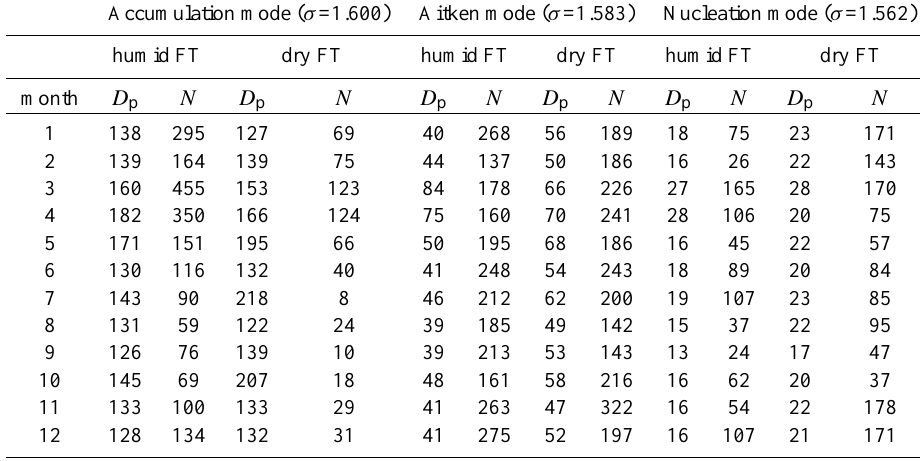
Table 4. Geometric mean diameter (nm) and number concentration (p./cm 3 ) of the three size distribution modes, as derived from multiple lognormal fits. Data coverage: March 2007–March